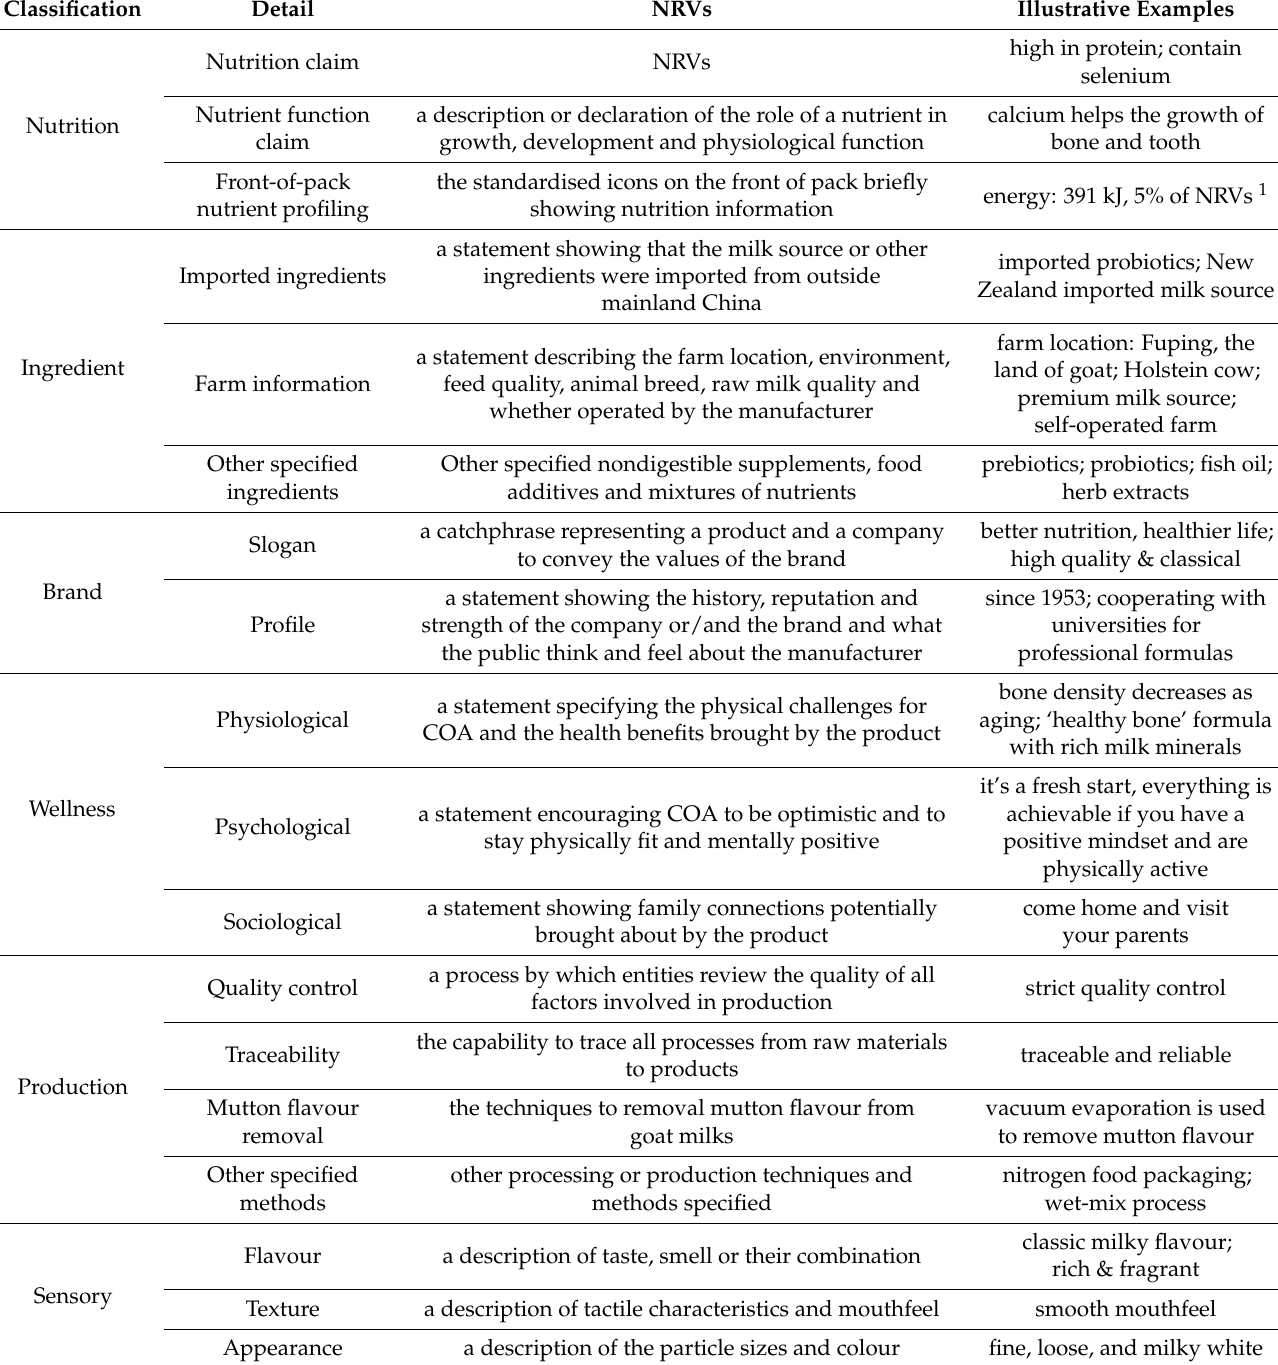
Table 1. Detailed classifications and working definitions of on-the-pack textual voluntary well-being messaging on milks targeting Chinese Older